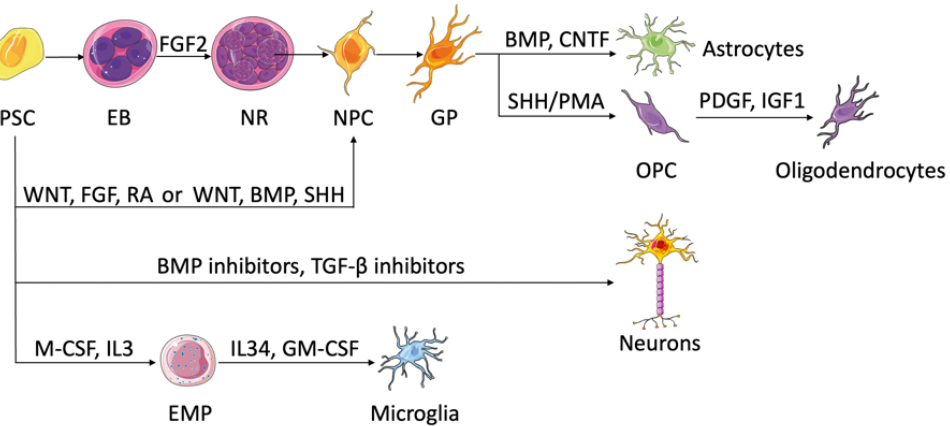
Figure 1. Brain cells and their differentiation from iPSCs. NPCs exist in neural rosettes and develop glial phenotypes spontaneously, which can differentiate into astrocytes by the addition of STAT pathway activators, such as BMP and CNTF. Following SHH or PMA addition, NPCs can turn into oligodendrocytes. PDGF and IGF1 are used in the process of maturation. NPCs can also come from iPSCs directly. Wnt, FGF, and RA establish anterior–posterior identities of NPCs, while Wnt, BMP, and SHH form dorsal–ventral identities. Neuron formation from iPSCs requires dual SMAD signaling inhibition using BMP and TGF- β inhibitors. Myelopoiesis takes place upon the addition of M-CSF and IL3. EMPs generate microglia once treated with IL34 and GM-CSF. EB, embryonic body; NR, neural rosette; NPC, neural progenitor cell; GP, glial phenotype; OPC, oligodendrocyte progenitor cell; EMP, erythromyeloid progenitor.